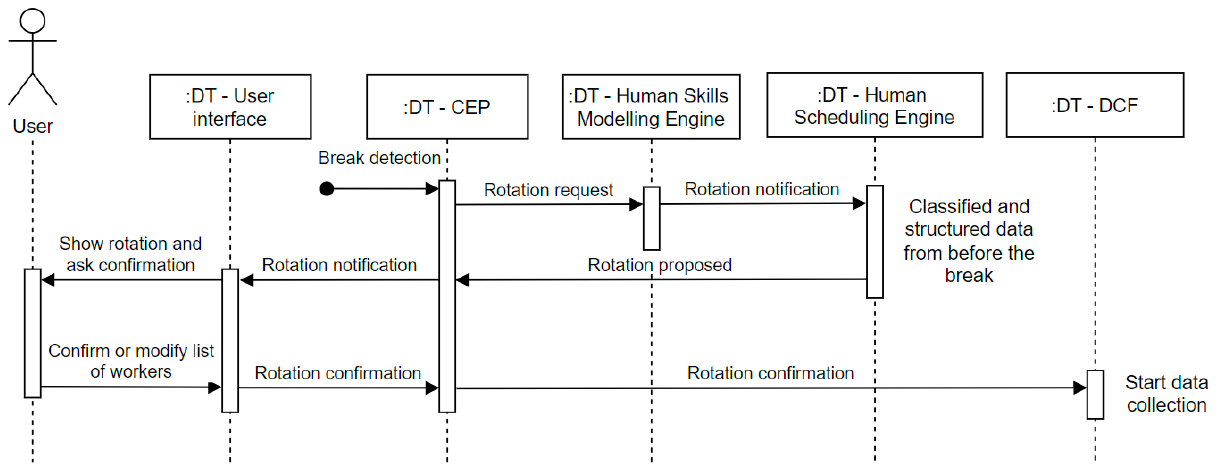
Figure 10. Sequence diagram of a rotation request.